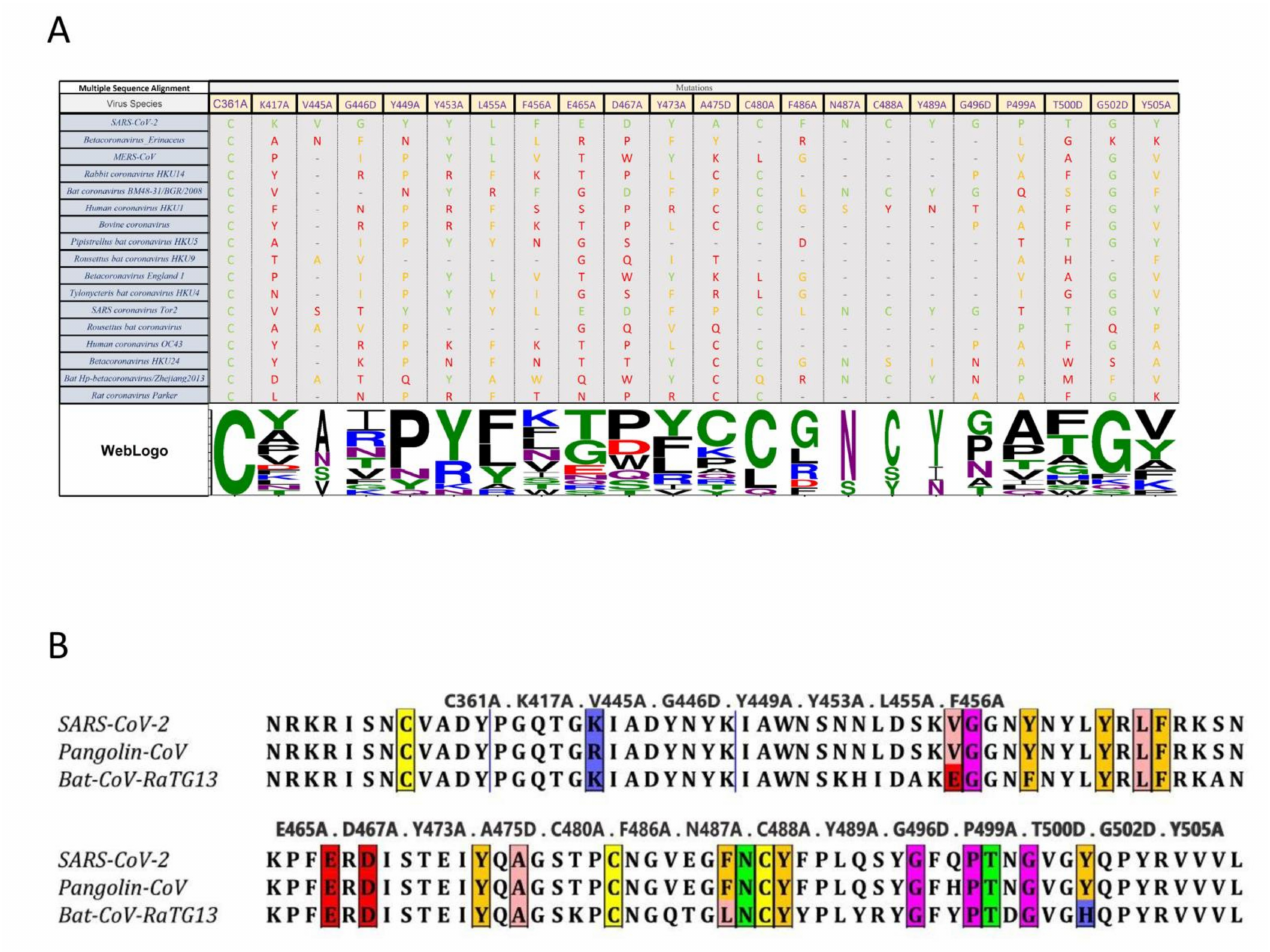
Figure 7. Multiple Sequence Alignment Analysis of RBD Mutants. ( A ) Only the target mutation sites are shown, and the non-target amino acids (AA) has been cut out from the alignment representation. The alignment coloring scheme is based on the chemical properties of each AA (each SARS-CoV-2 AA is green, the AA from the same chemistry is orange, and AA with different chemistry is red. WebLogo (http://weblogo.threeplusone.com (accessed on 1 February 2021)) representation shows a relative scale of the presence of each AA in each column. ( B ) Cross species comparison of RBD amino acids in SARS-CoV-2, Pangolin-CoV 2020, and Bat-CoV-RaTG13. Selected mutants are identified by colored boxes. Colored changes indicate RBD AA differences (V445A and F486A and